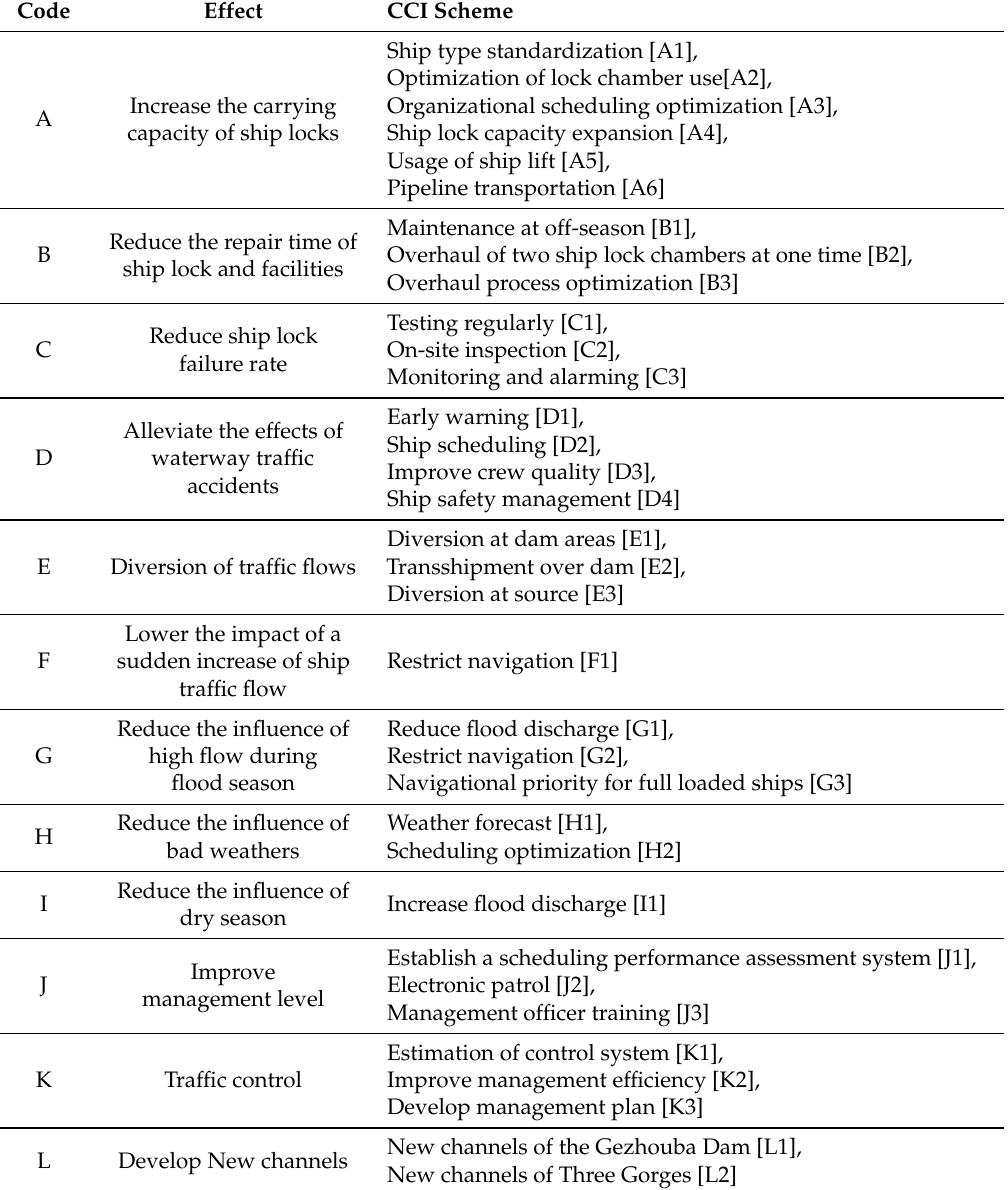
Table 7. CCI schemes related to ship locks of the Three Gorges